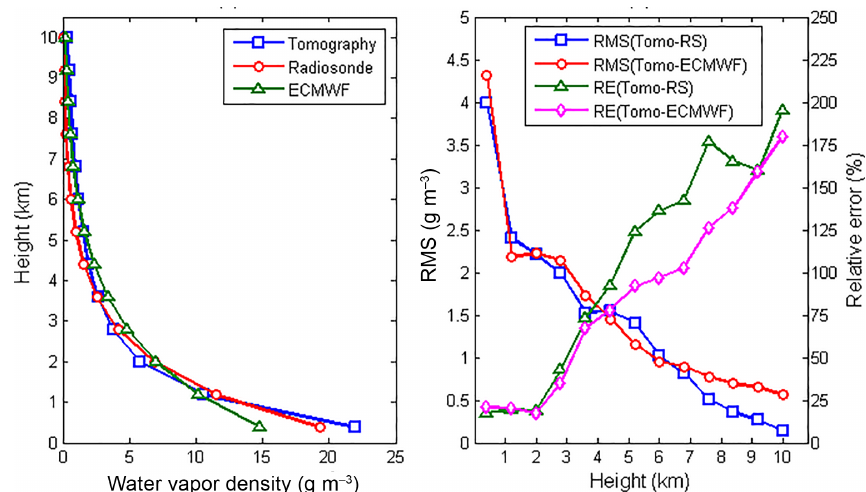
Figure 9. Water vapor density, RMS, and relative error change with height for Scheme 4.